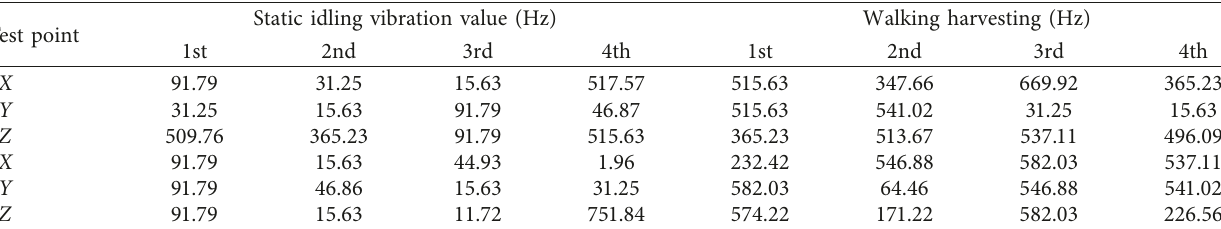
Table 5: Frequency response test results at 2